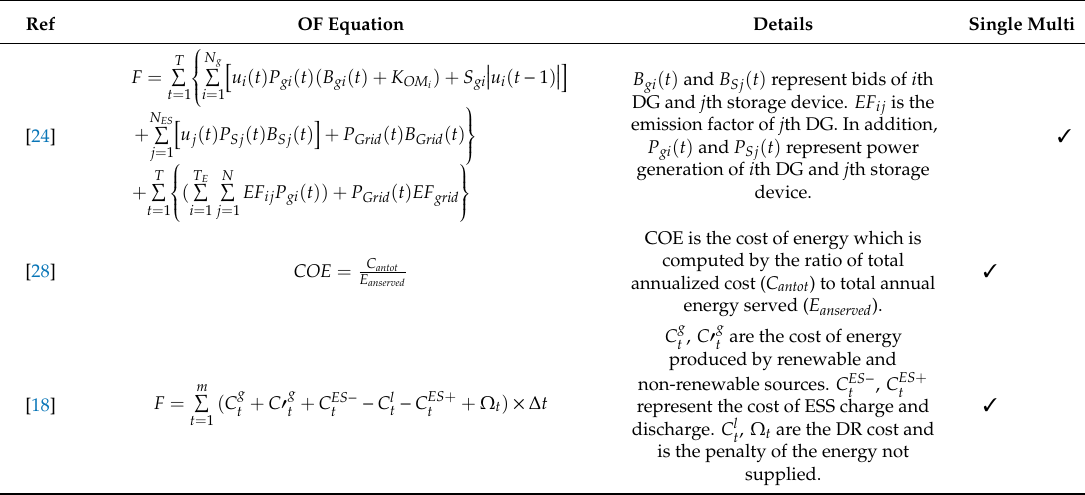
Table 2. Survey through collection of EMS objective